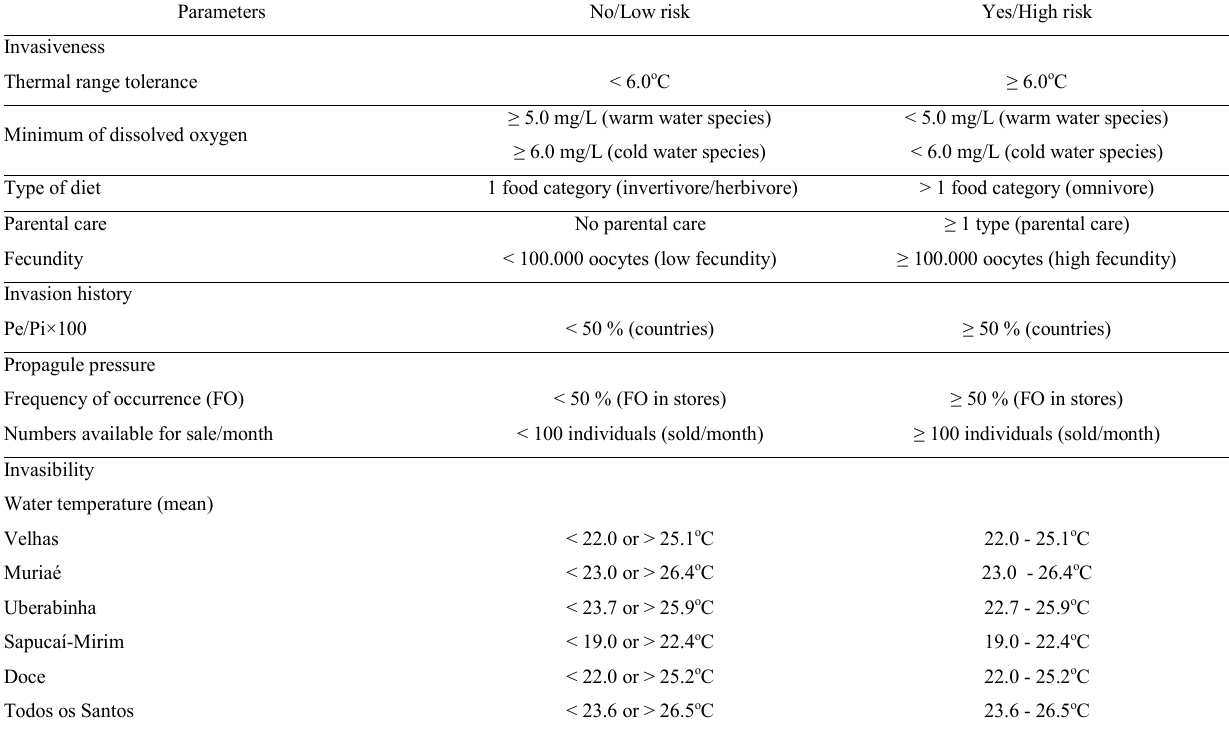
Table 2. Cutting values of parameters used in the model. Sources: Richter (1988), Degani (1990), Lawson (1995), Ford & Beitinger (2005), Çek & Gökçe (2005), Froese & Pauly